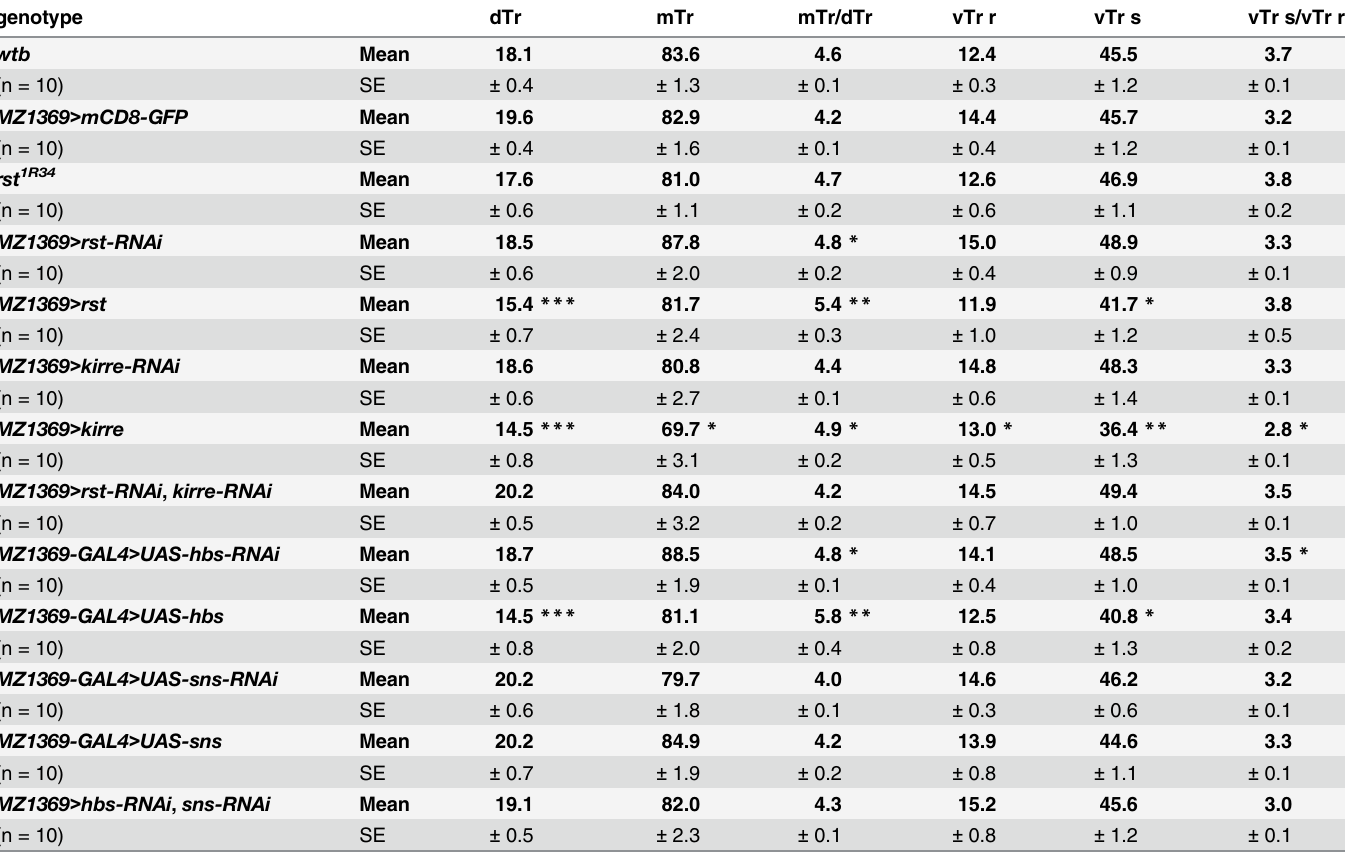
Table 1. Bristle numbers on dorsal and ventral side of the anterior wing margin.